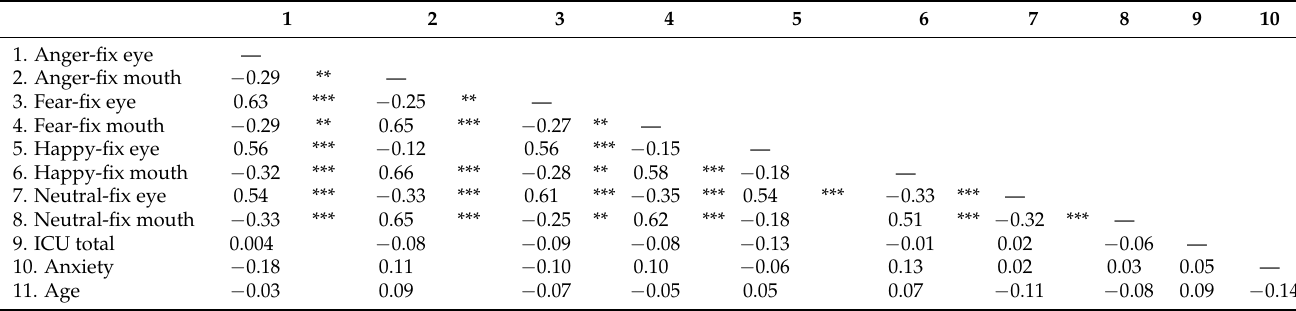
Table 1. Correlations ( Kendall’s tau ) among CU traits, anxiety, and age and proportion of reflexive saccades to the eye region when the mouth is fixated (“mouth”) and proportion of reflexive saccades to the mouth region when the eyes are fixated (“eye”).